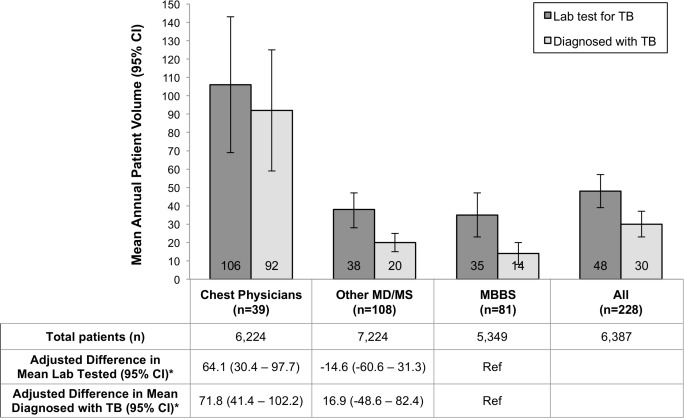
Mean annual volume of patients with tuberculosis (TB) in the past year according to practitioner training among private practitioners in Chennai.Dark bars show the mean (with 95% confidence intervals shown as error bars) number of patients for whom a laboratory test was sent specifically to diagnose TB in the past year, as reported by private practitioners with each level of training. Light bars show the mean number of people diagnosed with TB in that year. Data table shows the mean number of total patients seen in the past year.